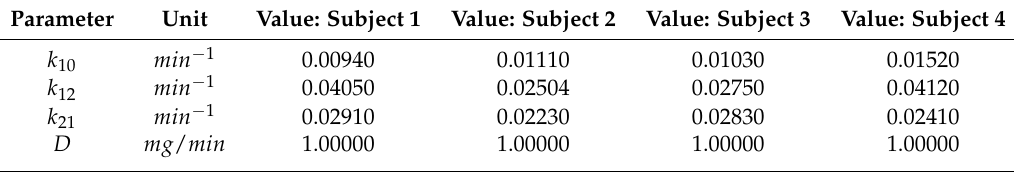
Table 1. Values for sisomicin kinetic parameters derived from two-compartment open model analysis of serum data after intravenous (I.V.) administration. These values are visualized in Figure 1 and are obtained from the work by Péchère et al.